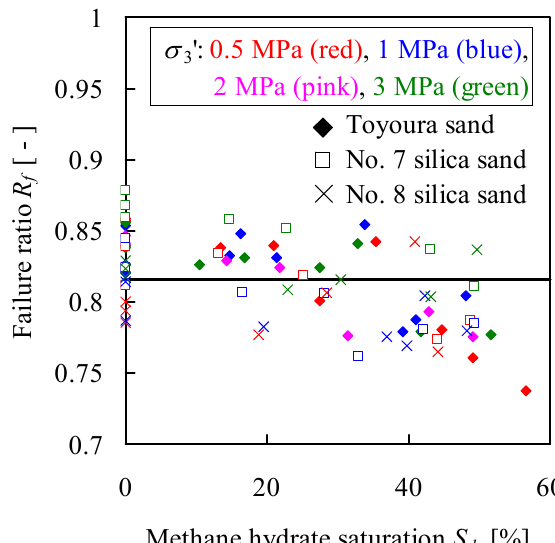
versus methane hydrate saturation S f